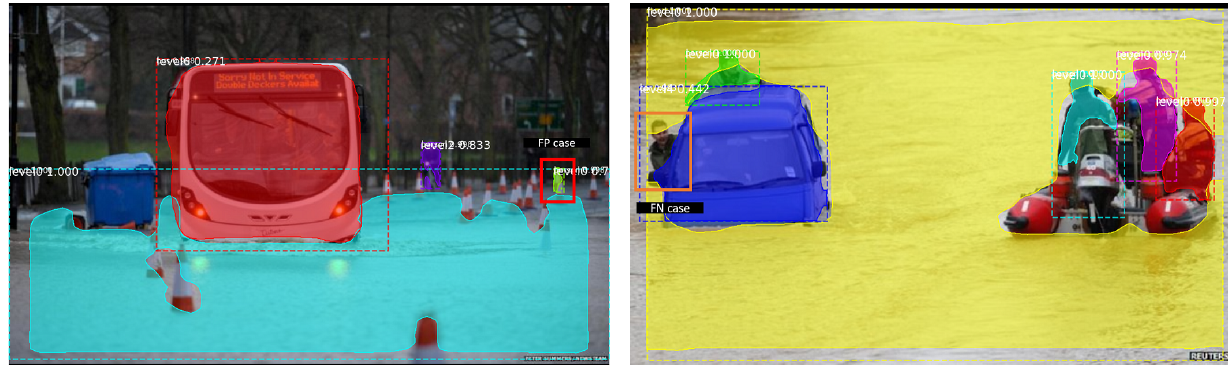
Figure 6. Shows two image prediction results. Left : FP case, where a road barrier is predicted as a person shown in red box. Right : FN case, where one person is not detected shown using orange